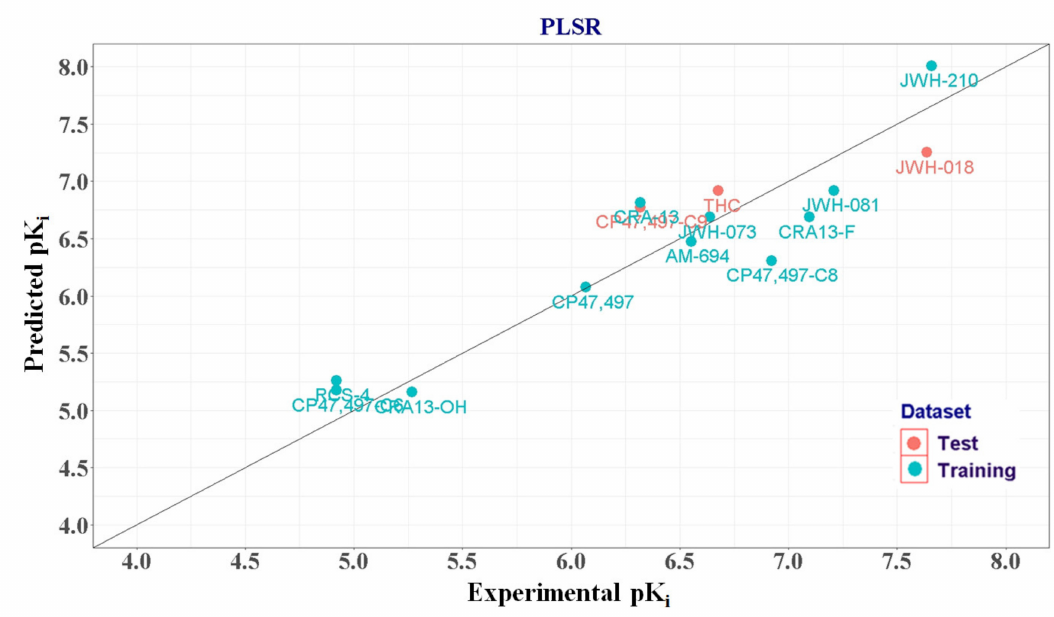
Figure 8. Correlation plot of predicted versus experimental pKi values of the quantitative structure– activity relationship model. PLSR, partial least square